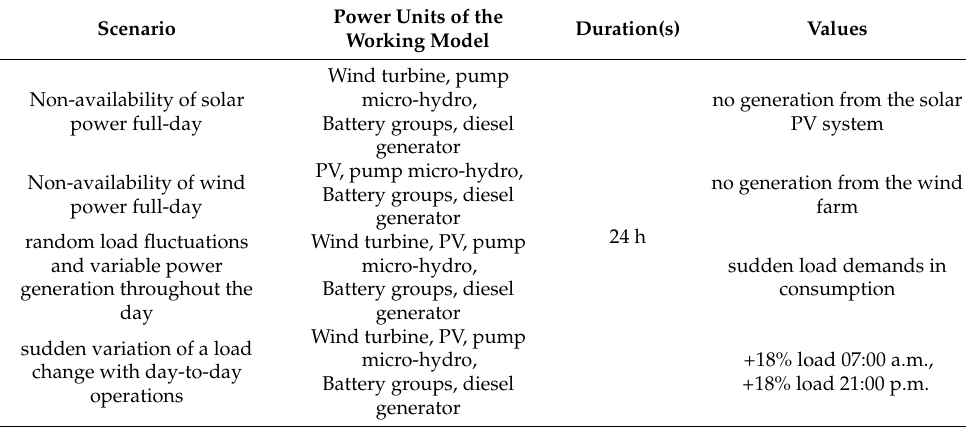
Table 2. Various microgrid system scenarios under the